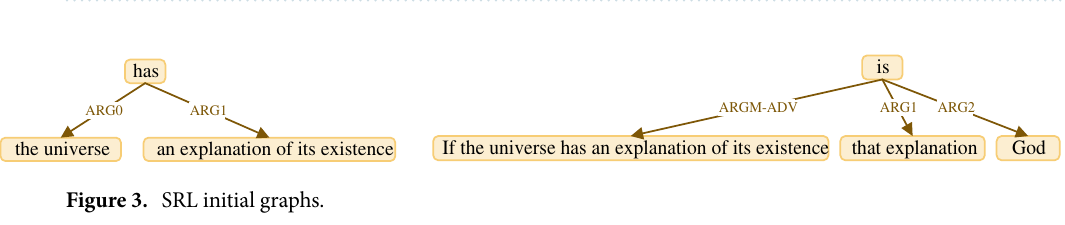
Figure 2. SRL system output, first and second rows illustrate arguments of first and second predicates respectively. Predicates are shown with red labels.